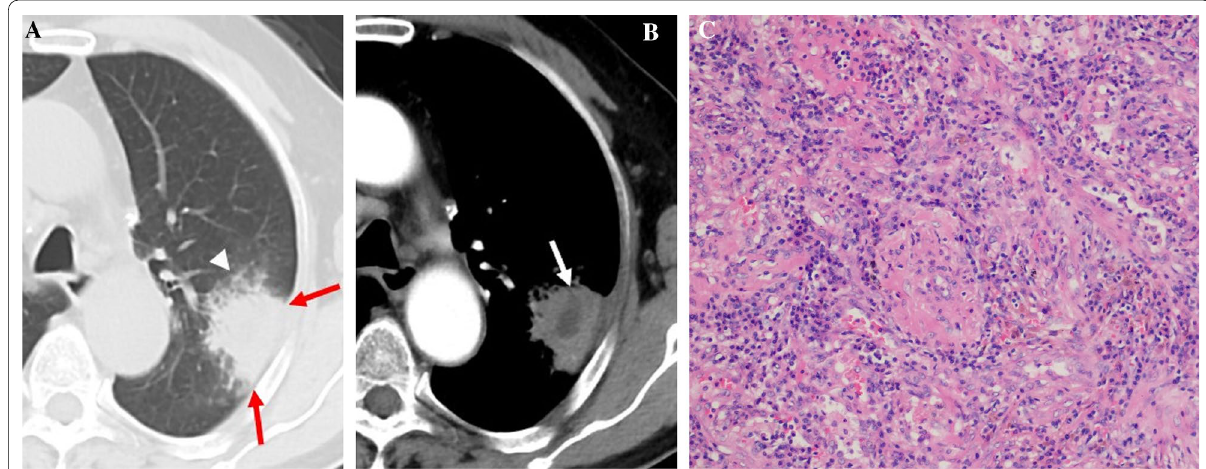
Fig. 4 L‑PIL in a 48‑year‑old man with left chest pain for 12 days. A Axial CT image of the lung window indicates localized consolidation with halo sign (white arrowhead) and pleural attachment (red arrow) in the left upper lobe. B Axial CT image of the mediastinal window in arterial phase indicates necrosis (white arrow) within the lesion. C Photomicrograph (hematoxylin and eosin staining,